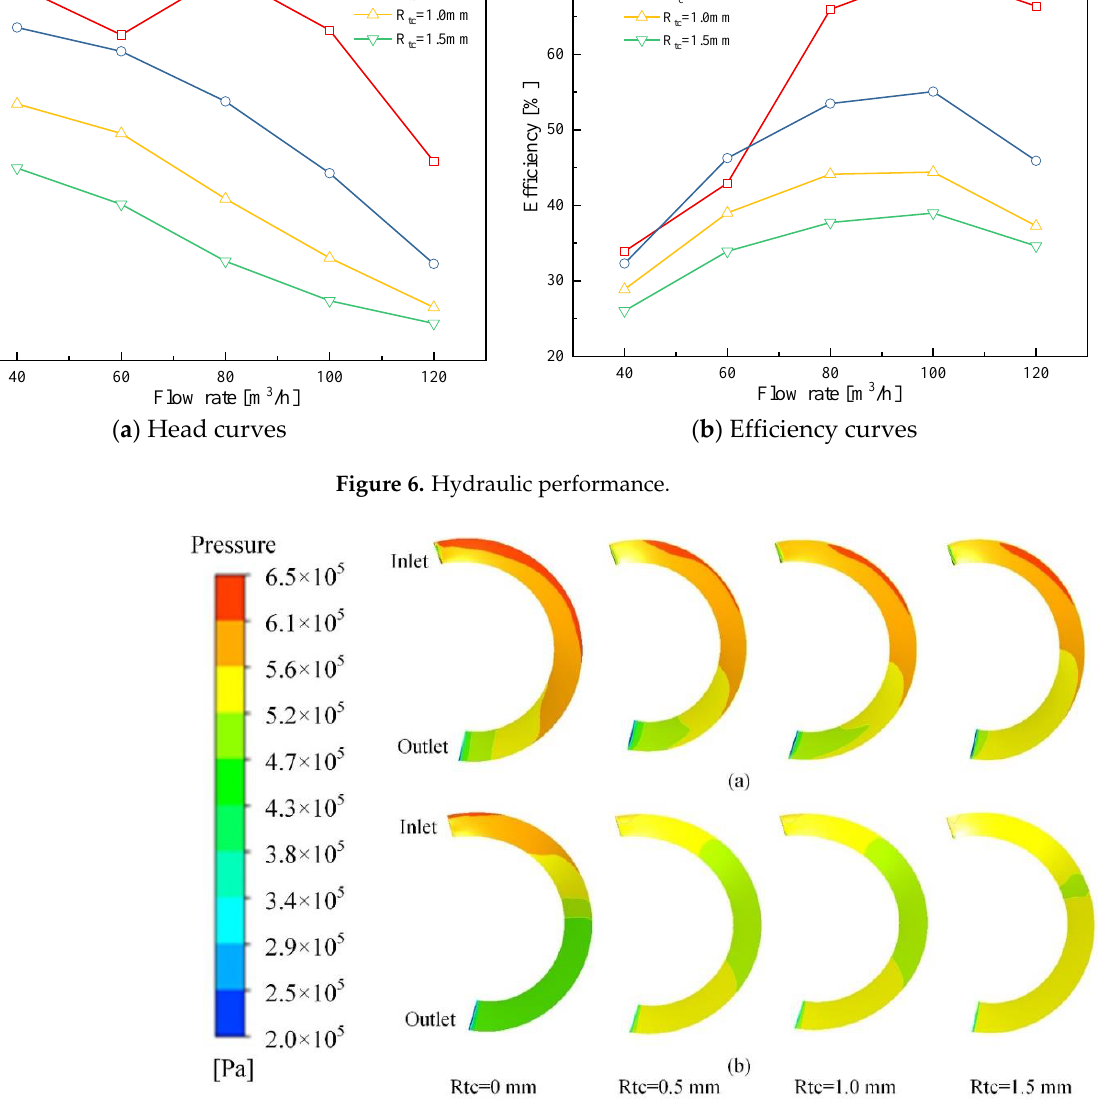
Figure 7. Pressure on blade surface. ( a ) pressure on PS; ( b ) pressure on SS.